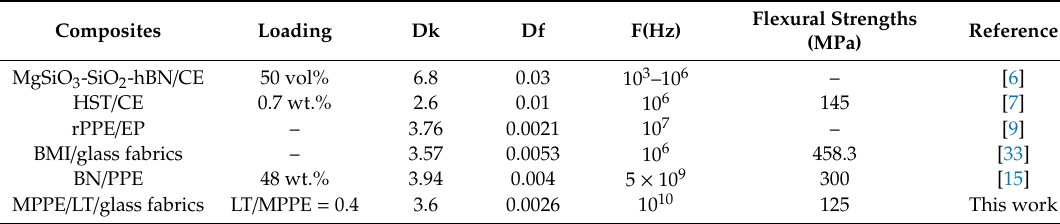
Table 2. Comparison of properties of polymeric